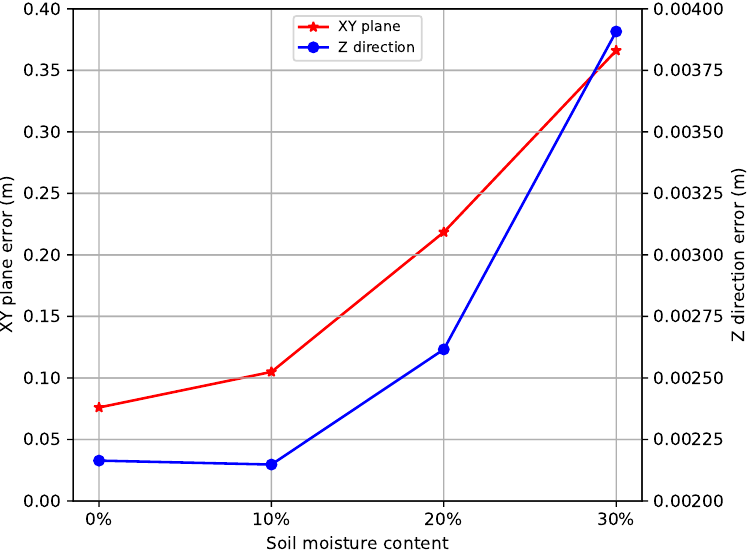
Figure 3. Localization error with respect to moisture content. The localization accuracy using time of arrival-based ranging requires an added provision of clock synchronization among all the nodes in the network. Indeed, the clock synchronization is built into our network as it is also needed for scheduling [28,29]. Thus, boundedness of clock drifts can be guaranteed by resynchronizing the sensor nodes ahead of collecting the localization data. We studied the effect of the drift in sensors’ clocks in Figure 4. The X-axis represents the maximum drift in the sensors’ clocks from true time in either direction. We used a uniform random number generator to simulate the clock drifts, and as seen in Figure 4, the clock drift increases the localization error increases linearly.